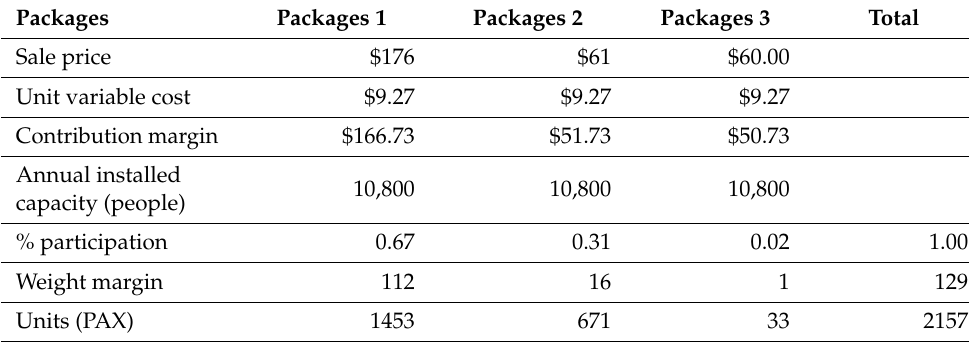
Table 14. Breakeven